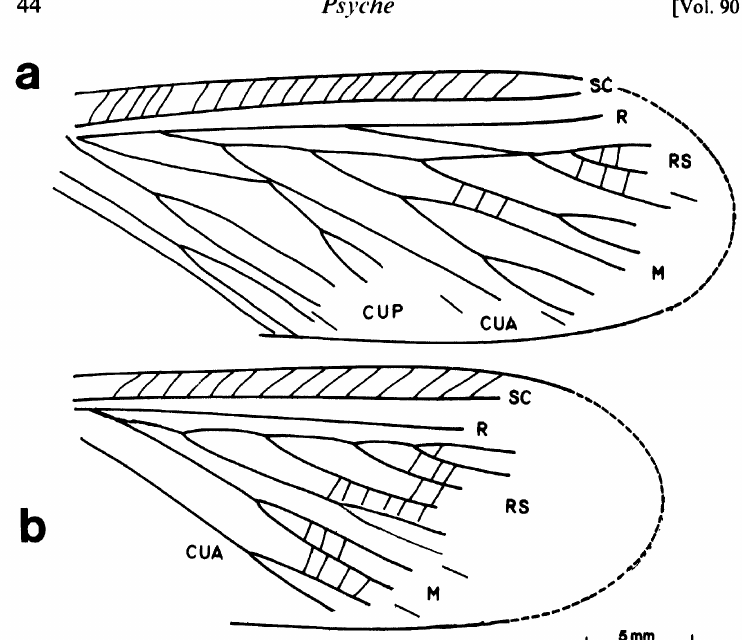
Fig. 26. Gerarulus radialis, drawings based on holotype no. YPM 37. a. fore wing. b. hind wing.